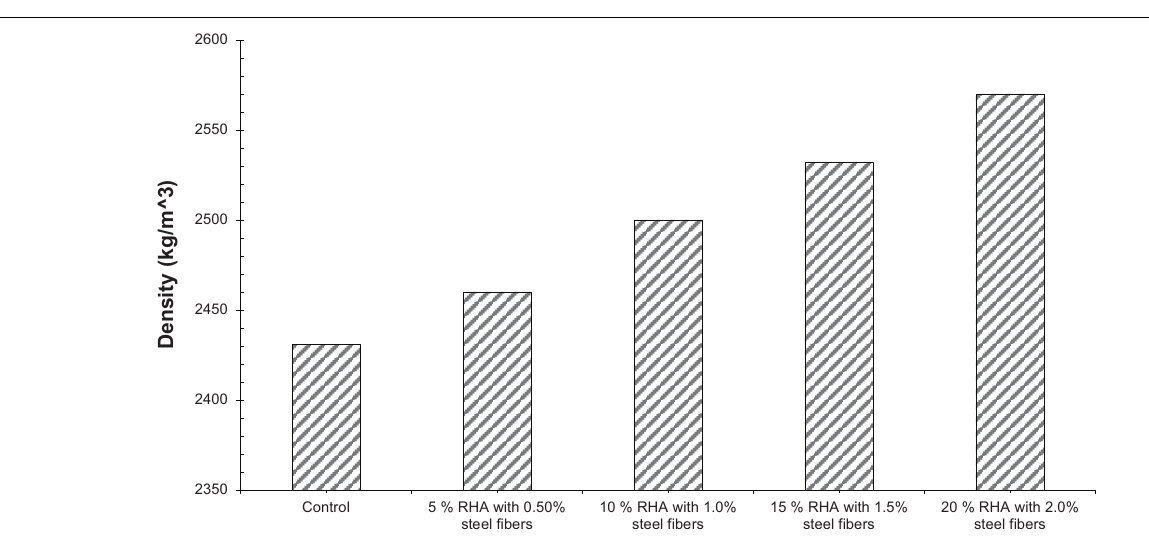
FIGURE 13 | Density (with steel fibers and